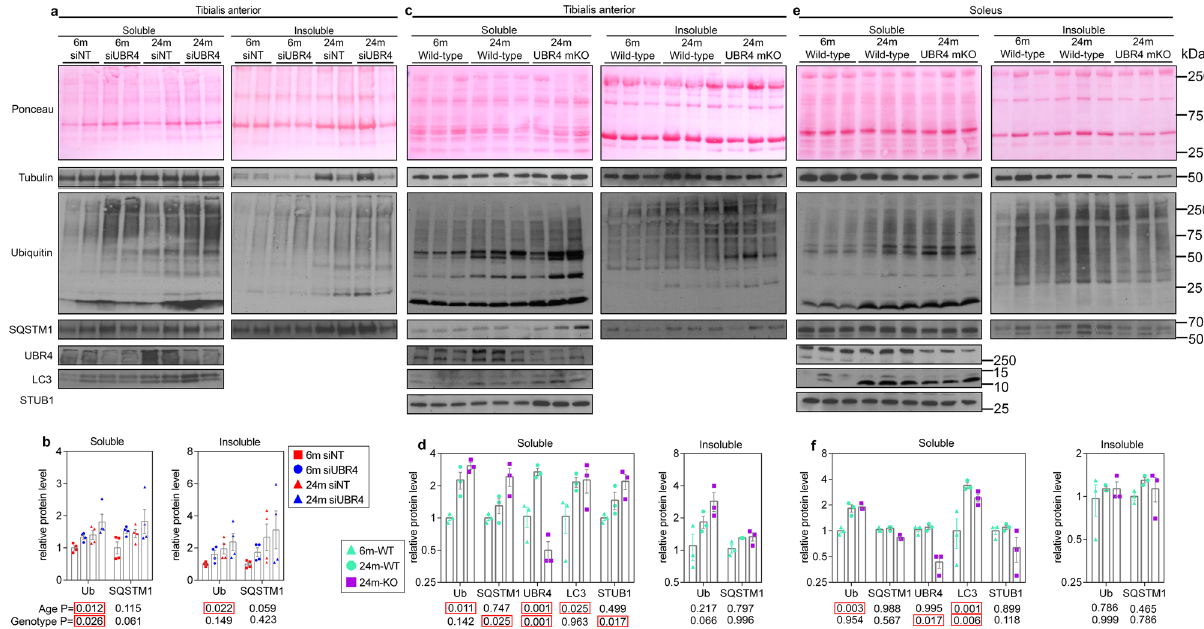
Fig. 3 Defective protein quality control in aging skeletal muscles is exacerbated by UBR4 loss. Western blotting of detergent-soluble and insoluble proteins fractions from young and old tibialis anterior muscles with a UBR4 siRNA and from c UBR4 mKO mice, and e soleus muscles from UBR4 mKO mice, with quantitation, respectively, shown in b , d , and f . Ubiquitin and SQSTM1/p62 accumulate with age in both soluble and insoluble fractions of tibialis anterior muscles, and UBR4 loss leads to increased accumulation of these proteostasis markers. LC3 levels increase with age but are mostly unaffected by loss of UBR4. UBR4 loss increases STUB1/CHIP levels in the tibialis anterior but not in the soleus muscle. In the soleus, insoluble accumulation of ubiquitin and SQSTM1 is not evident, and only ubiquitin and LC3 accumulate in soluble fractions with age. Loss of UBR4 in the soleus muscle does not affect the accumulation of proteostasis markers, indicating that the soleus is better protected than the tibialis anterior muscle from proteostasis challenges that occur with aging. In b , n = 4 biologically independent mice with matched muscles from contralateral legs are employed for comparison of NT siRNAs versus UBR4 siRNAs. In d , f , n = 3 biologically independent muscles from separate mice. Data are presented as mean ± SEM. Statistics for b , d , and f were calculated by using two-way ANOVA with Tukey ’ s post hoc test with adjustment for multiple comparisons. Similar results were obtained from two independent sets of biological